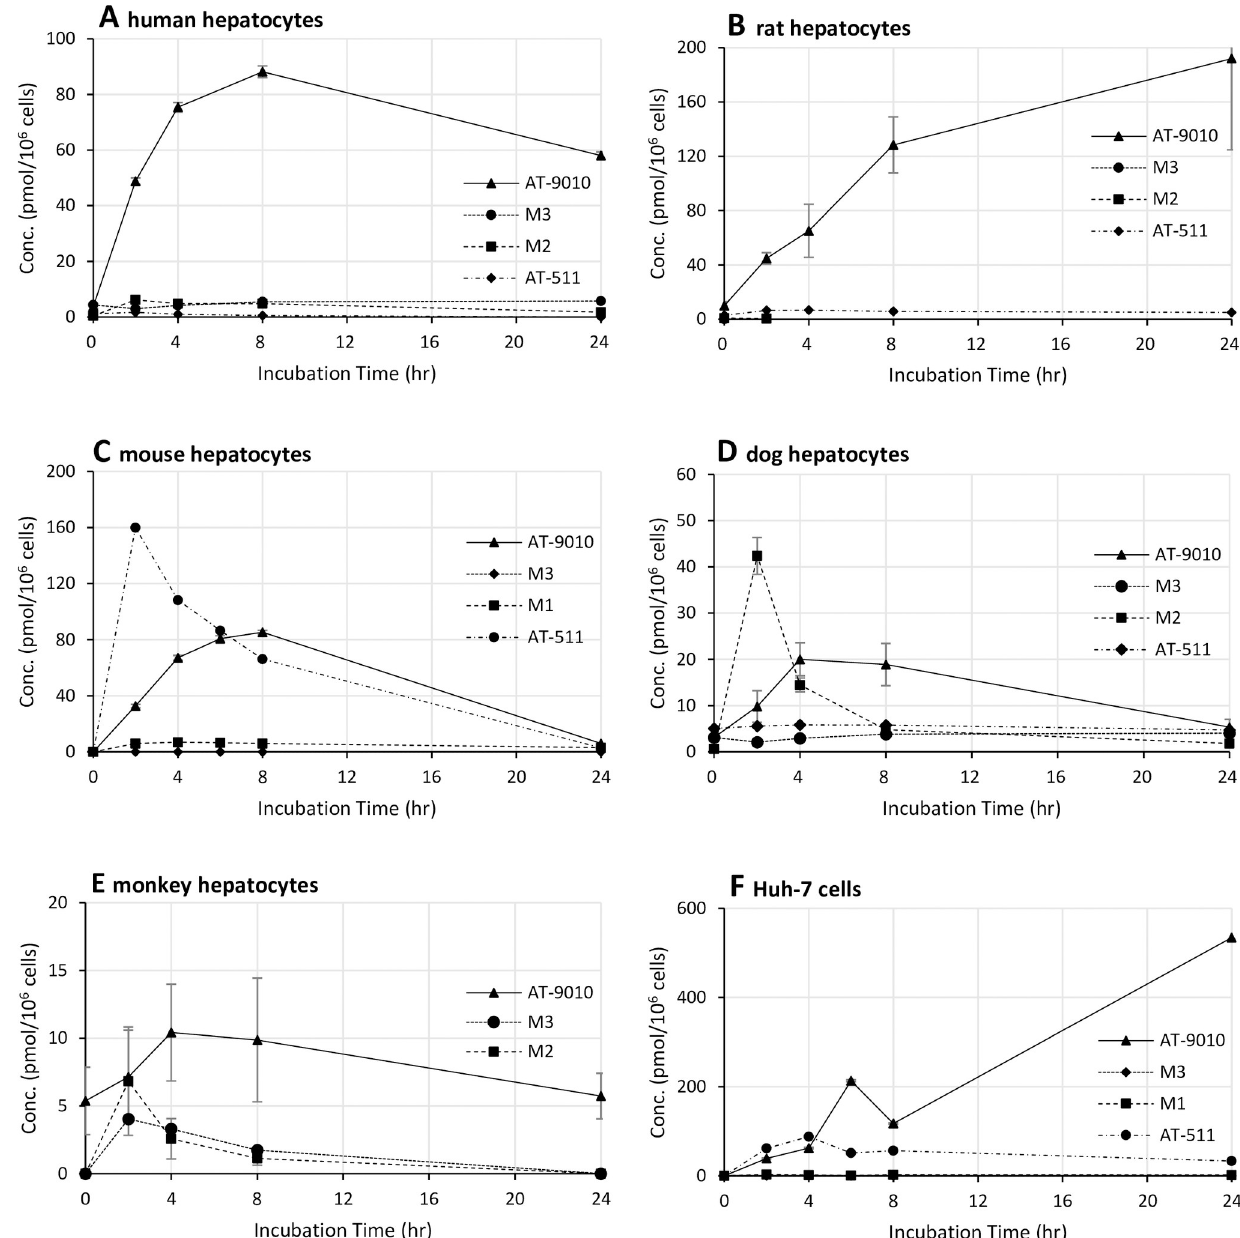
Fig 5. Intracellular concentrations of AT-511 and its phosphorylated metabolites in liver cells. (A) mixed gender human hepatocytes, (B) male rat hepatocytes, (C) male mouse hepatocytes, (D) male dog hepatocytes, (E) male cynomolgus monkey hepatocytes and (F) Huh-7 cells. Cells were incubated for 24 h with 10 μ M AT-511 in triplicate, collected, lysed and the lysates measured for concentrations of AT-511, AT-9010, M2 and M3 by LC-MS/MS. Data are expressed as mean ± SD. https://doi.org/10.1371/journal.pone.0227104.g005 PLOS ONE | https://doi.org/10.1371/journal.pone.0227104 January 8,